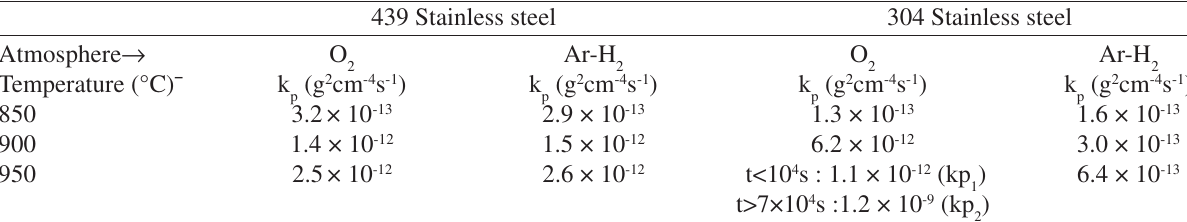
Table 2. Parabolic oxidation